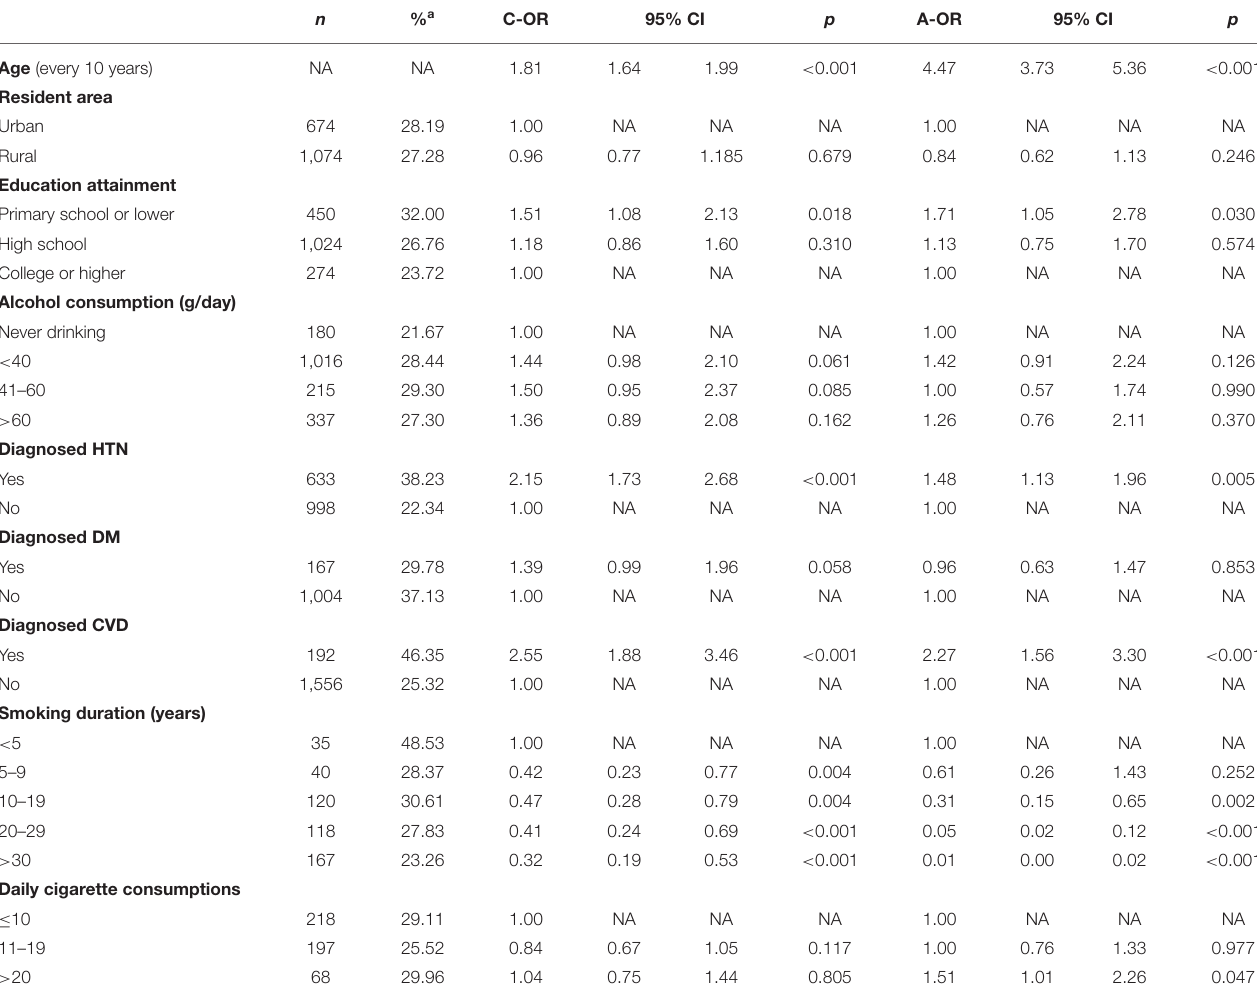
TABLE 4 | The associated factors of smoking cessation among male ever-smokers in Hebei Province, central China, 2017. n % a